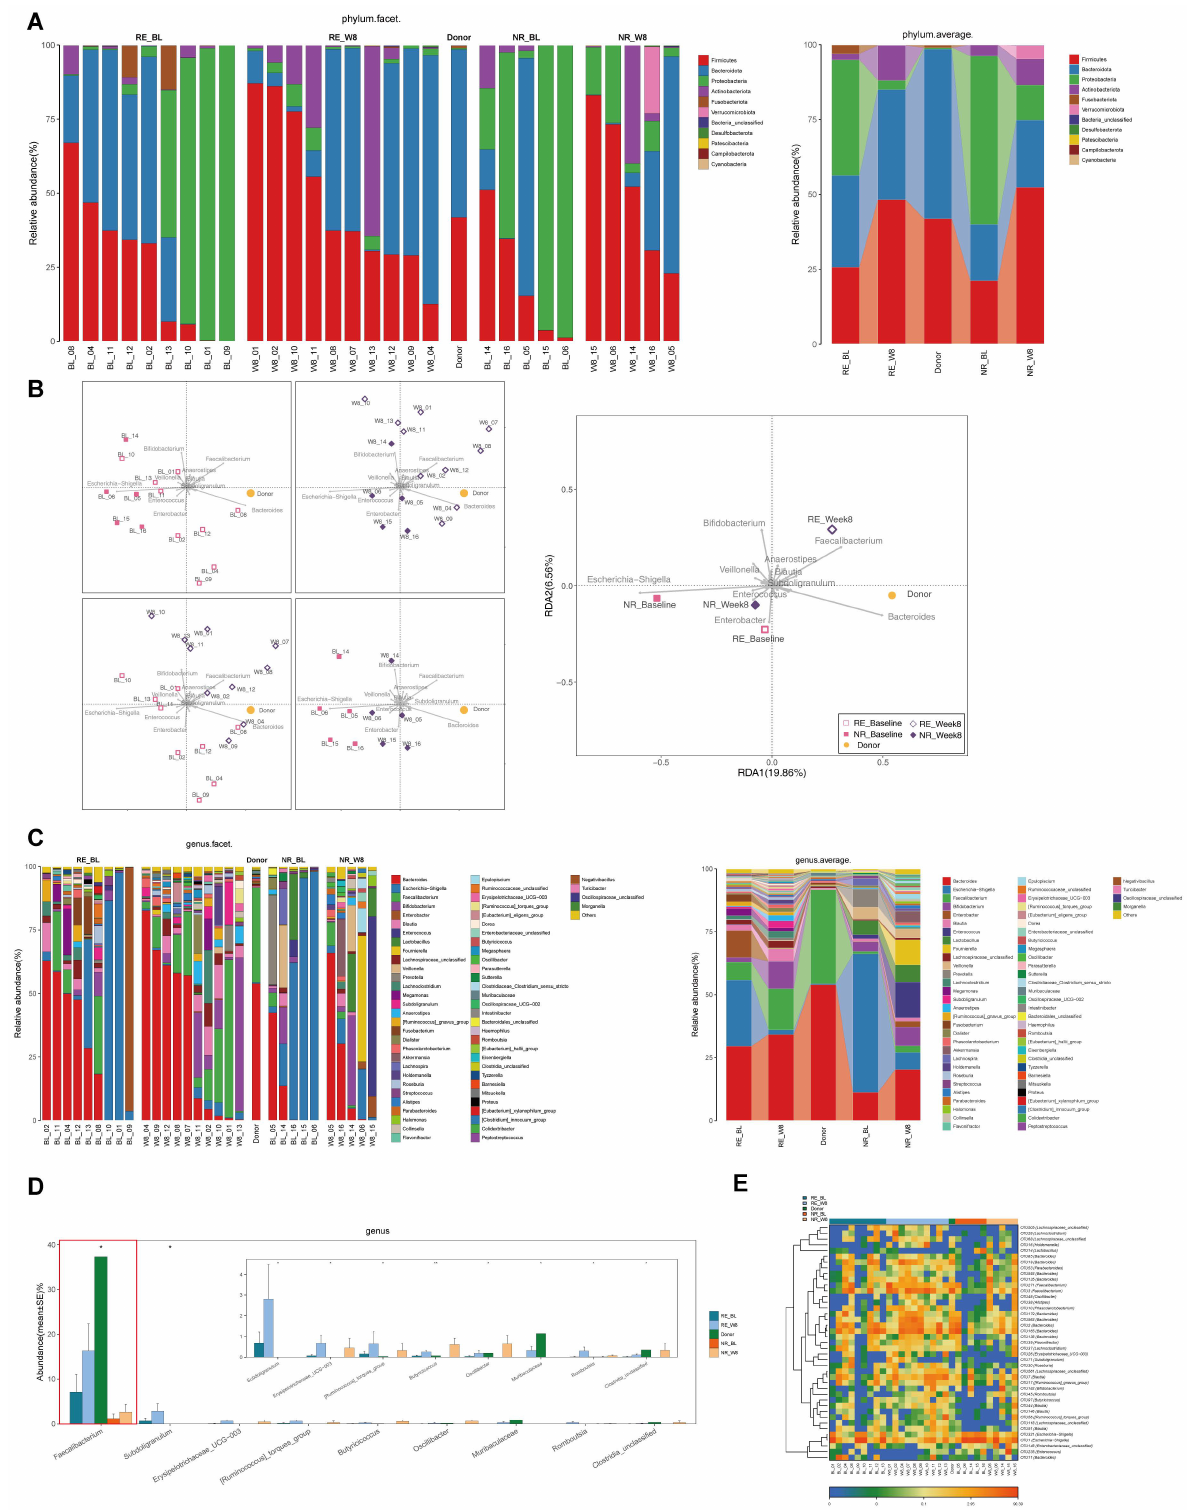
Figure 4. Microbiome communities shift is associated with better outcomes in responders (RE) group after fecal microbiota transplantation (FMT). ( A ) Relative abundance of phyla in intestinal microbiota. ( B ) Redundancy analysis (RDA) of the microbiota. ( C ) Relative abundance of genera in intestinal microbiota. ( D ) The Kruskal–Wallis rank testing of the microbiota. ( E ) Heatmap of selected most differentially abundant features at genus level. (BL, baseline; RE, responders; NR, non-responders). (* p <